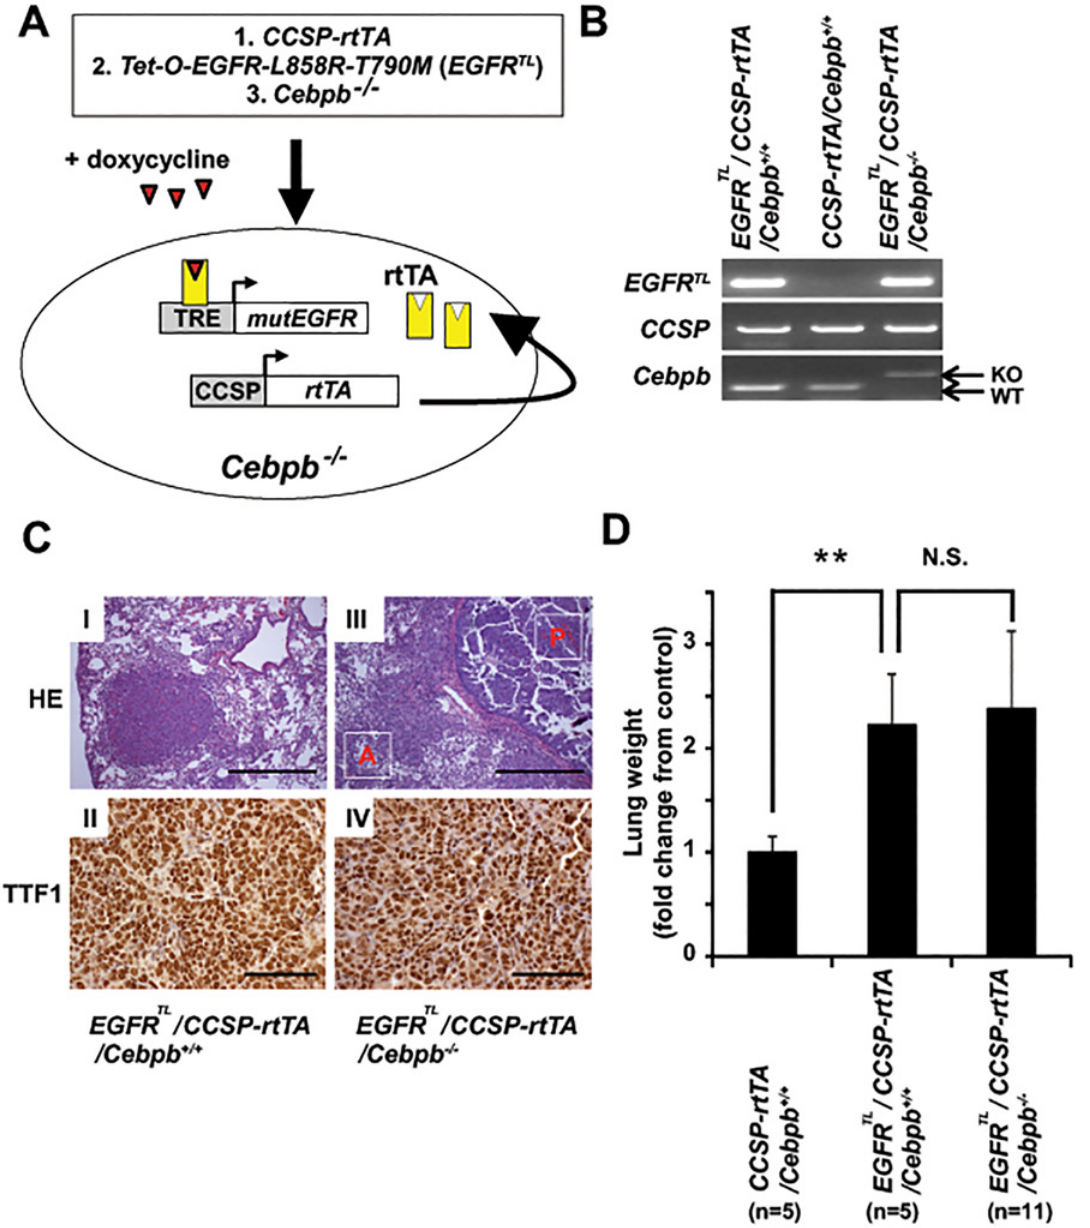
Fig 5. Deletion of Cebpb does not affect tumor burden in vivo . (A) Scheme of the strategy generating lung specific inducible EGFR-TL transgenic mice with Cebpb knockout background. (B) Genotype of EGFR TL /CCSP-rtTA/Cebpb +/+ , CCSP-rtTA/Cebpb +/+ and EGFR TL /CCSP-rtTA/Cebpb -/- mice. (C) Representative images of H&E staining and immunohistochemistry of lungs isolated from EGFR TL /CCSPrtTA/Cebpb +/+ (I and II) or EGFR TL /CCSPrtTA/ Cebpb -/- (III and IV). Lung sections were stained with H&E (I and III) and anti-TTF1 (II and IV) antibodies. “ A ” indicates an area with bronchioalveolar growth pattern and “ P ” indicates an area with bronchial papillary growth pattern. (D) Lung weight isolated from mice treated with doxycycline for 8 – 12 weeks. We analyzed 5 CCSP-rtTA/Cebpb +/+ , 5 EGFR TL /CCSP-rtTA/Cebpb +/+ , and 11 EGFR TL /CCSP-rtTA/Cebpb -/- mice. Data represent mean ± standard deviation. ** denotes p (cid:1) 0.01. N.S. denotes not